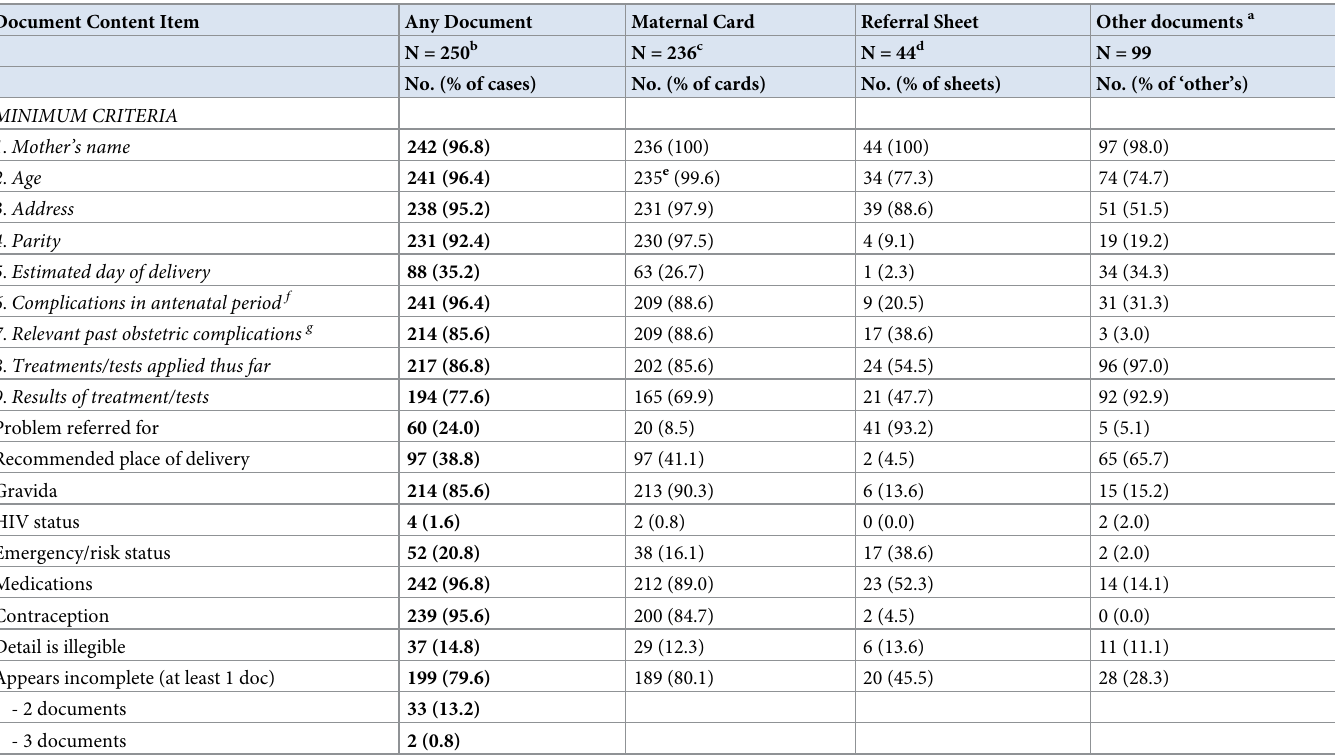
Table 2. Contents of women-held documents at